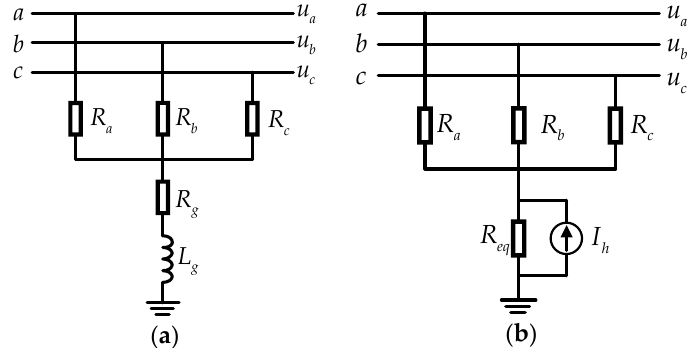
Figure 4. Fault model and its equivalent circuit model for transient simulation: ( a ) fault model; ( b ) equivalent circuit model for transient simulation.